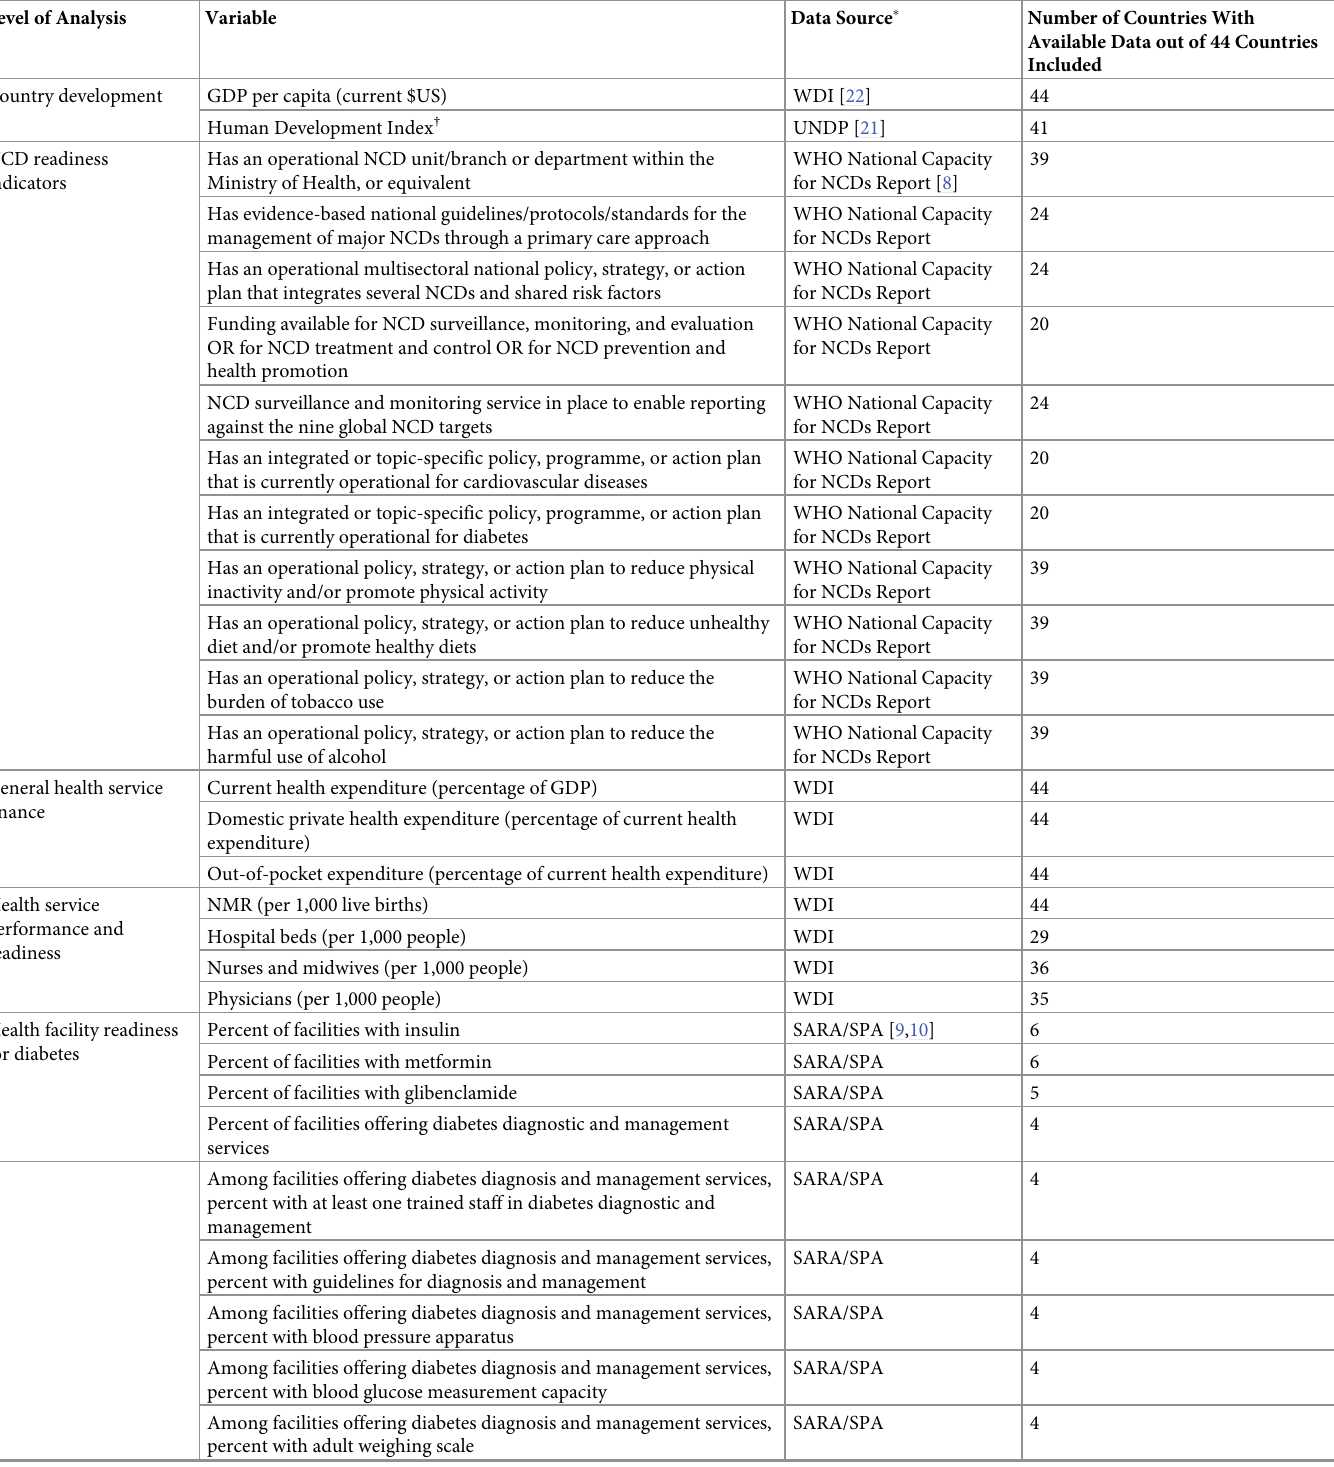
Table 1. Summary of independent variables included in